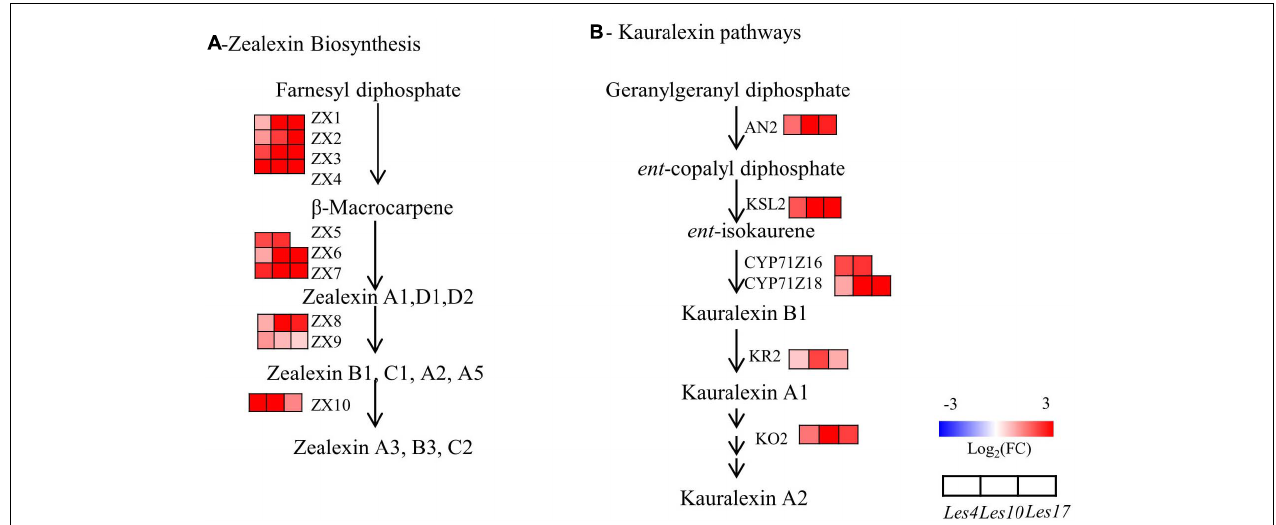
FIGURE 7 | The transcriptomics analysis of zealexins and kauralexins biosynthesis. (A) Transcriptional changes of zealexins biosynthetic genes in Le4 , Les10 , and Les17 mutants compared to their respective wild type (WT). (B) Transcriptional changes of kauralexins biosynthetic genes in Le4 , Les10 , and Les17 mutants compared to their respective WT. For (A,B) , different rows represent the different homolog genes encoding the related enzyme, with each column representing different genotypes and different colors indicating different gene expression levels. The number below each metabolite is the log 2 (fold change) value. The detailed information of genes involved in zealexins and kauralexins biosynthesis is available in Supplementary Table 17 . Double arrows in sequence represent omitted metabolites and genes. ZX, Zealexin; TPS, Terpene Synthase; AN2, Anther Ear 2; KSL, Kaurene Synthase-Like, CYP, Cytochrome P450, KO2, Kaurene Oxidase 2; KR2, Kauralexin Reductase